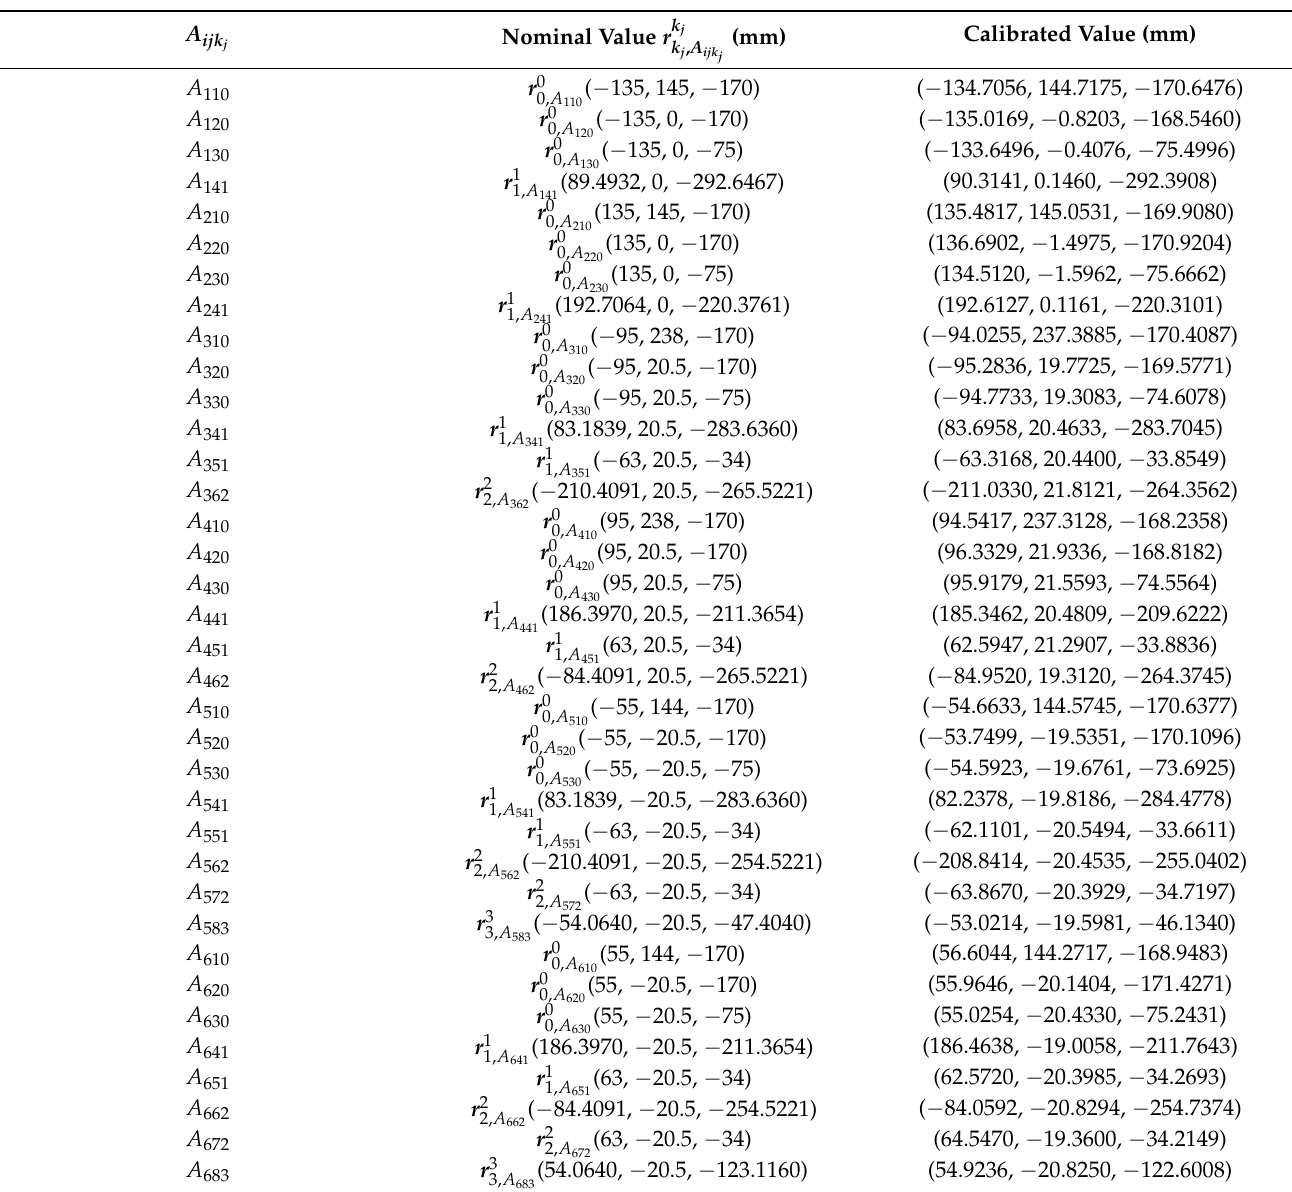
Table 4. Nominal and calibrated values of attachment points’ coordinates.